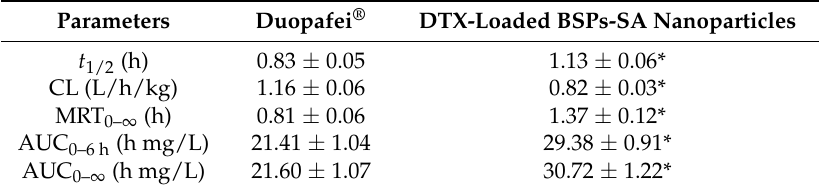
Figure 12. The mean plasma concentration–time curves of docetaxel (DTX) in 4T1 tumor-bearing BALB/c mice after a single tail vein injection of 25 mg/kg Duopafei ® and 25 mg/kg DTX-loaded BSPs-SA nanoparticles. Data are presented as mean ± SD ( n = 5). Table 1. Plasma pharmacokinetic parameters of DTX-loaded BSPs-SA nanoparticles and Duopafei ® with a dose of 25 mg/kg docetaxel after tail vein injection. Data are presented mean ± SD ( n = 5).